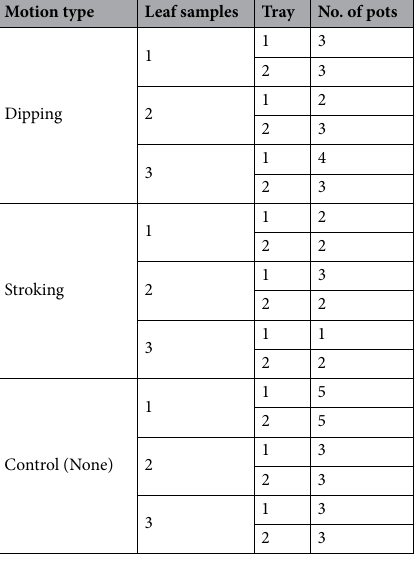
Table 2. Experiment 3 treatment group distribution. * Row 8 consisted of five pots, while rows 1–7 consisted of three pots each.